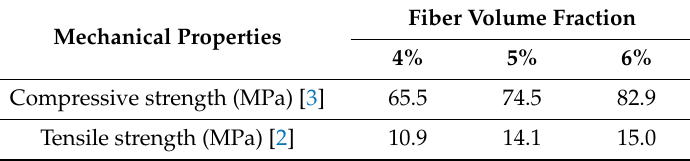
Table 5. Compressive and tensile strength of SIFRCCs [2,3].